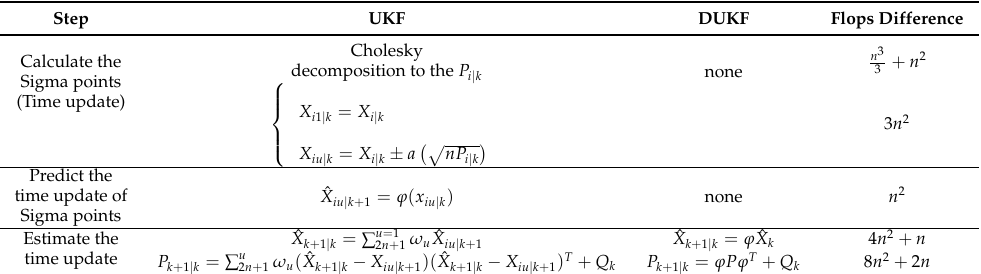
Table 1. The difference in Computation Cost of unscented Kalman filter (UKF) and derivative UKF